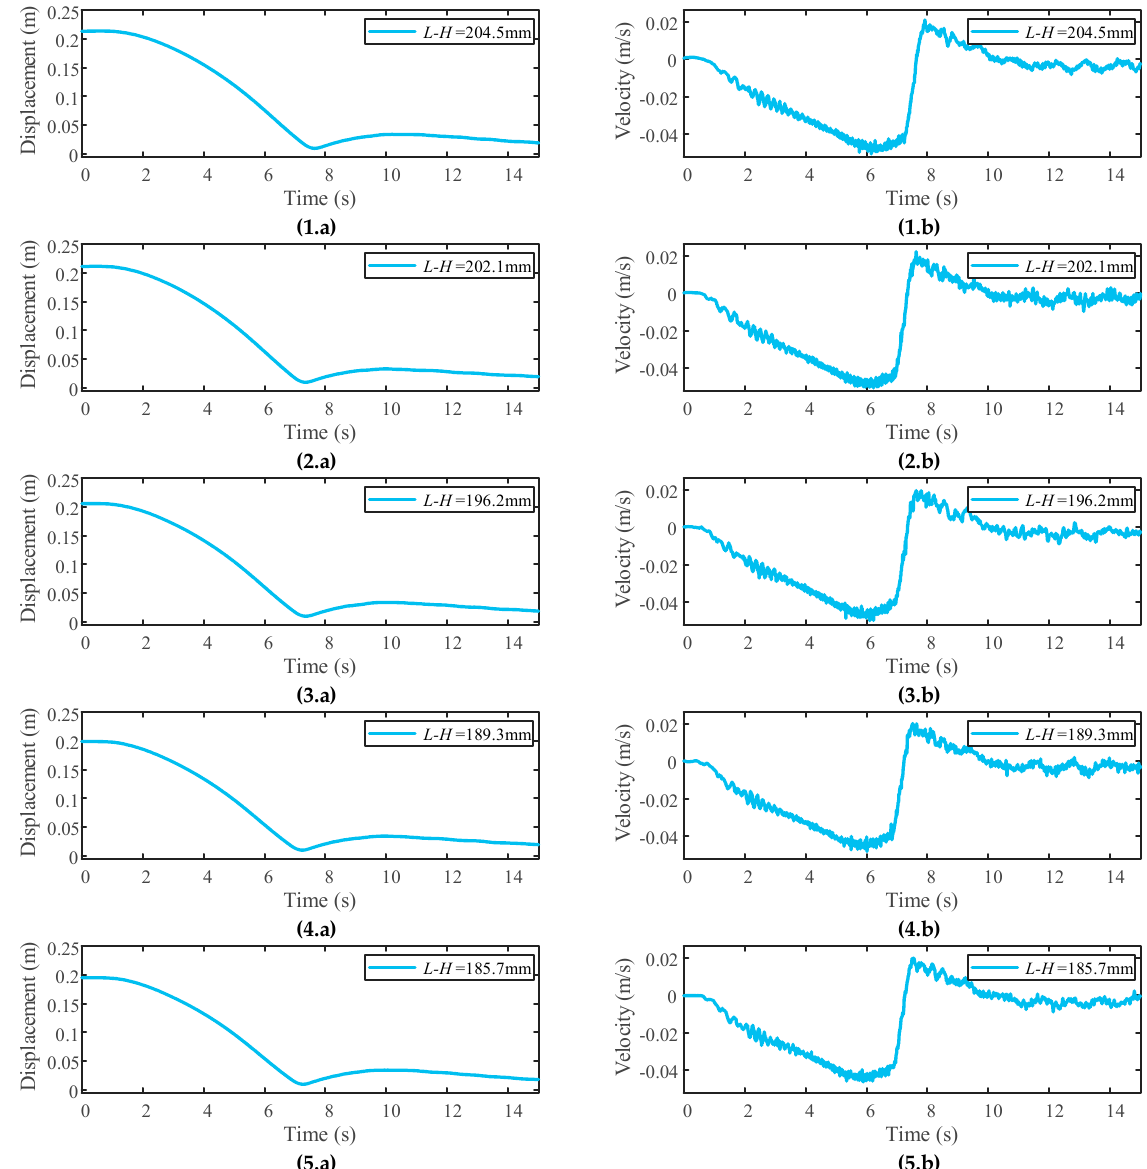
Figure 6. The relative displacements as well as velocities during the processes of the DBoBSI in ISD system. ( 1.a – 5.a ) Displacements; ( 1.b – 5.b ) Velocities.